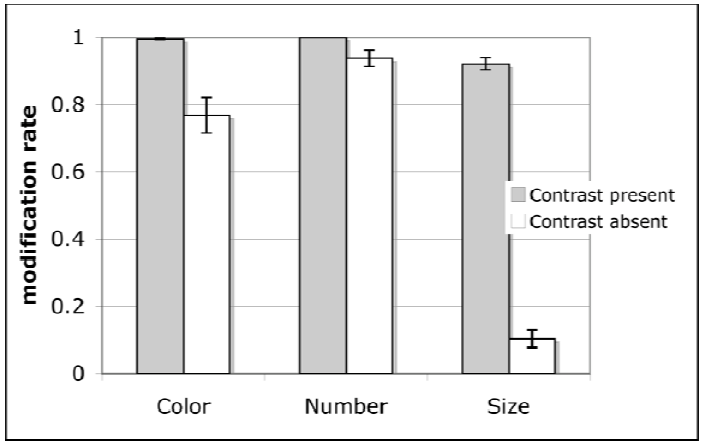
Figure 3. Modification rates for color, number, and size trials in Experiment